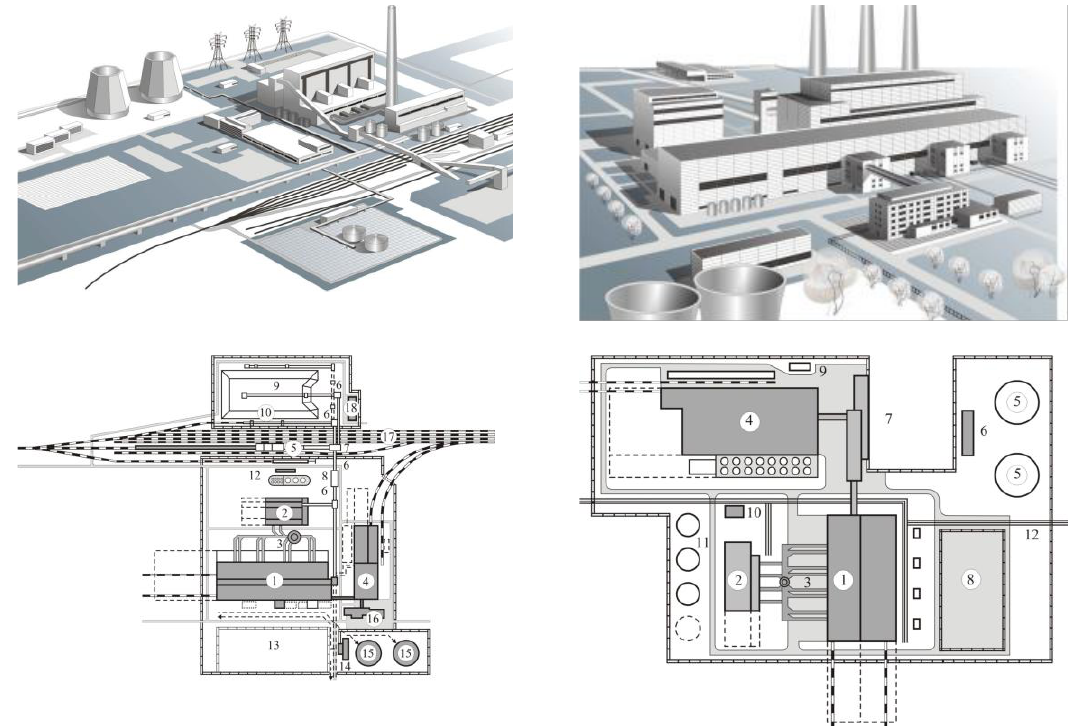
Figure 2. General plan view of coal-fired TPP and gas-fired TPP, (Ohlopkova,